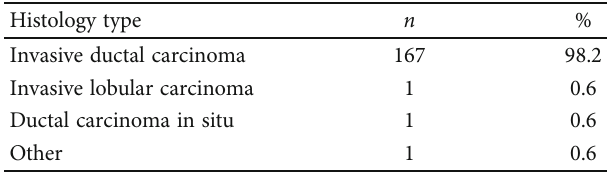
Table 5: Histology type distribution ( n = 170